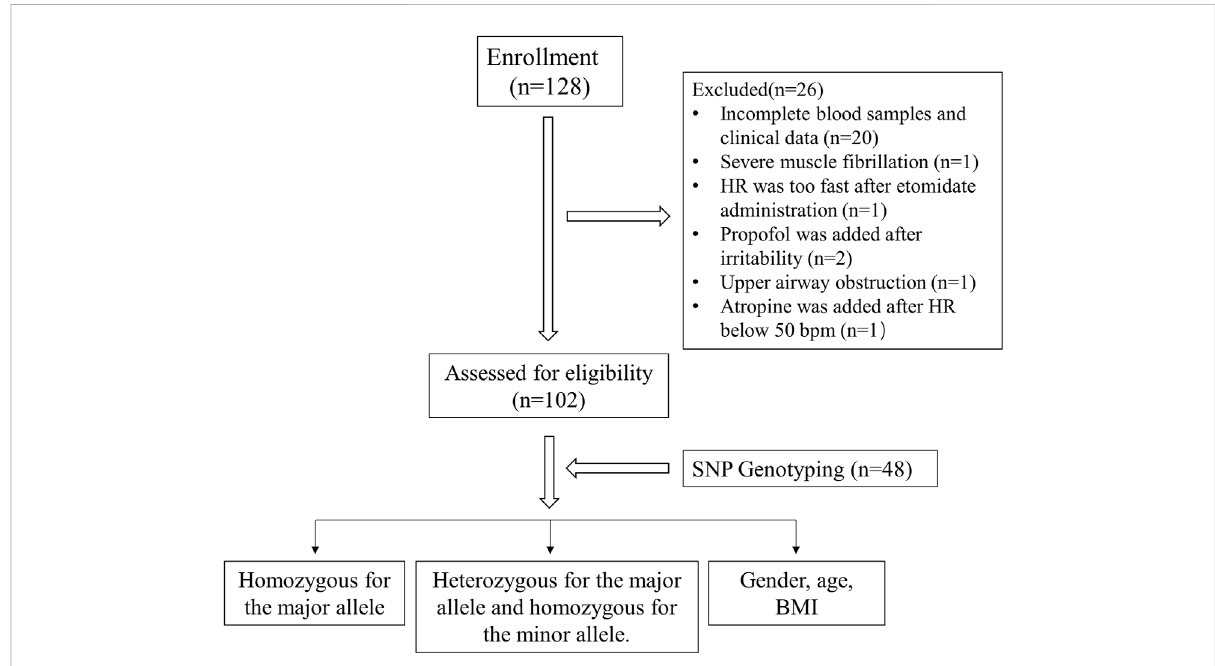
FIGURE 1 The study design and fl ow chart. SNP, single nucleotide polymorphism. HR, heart